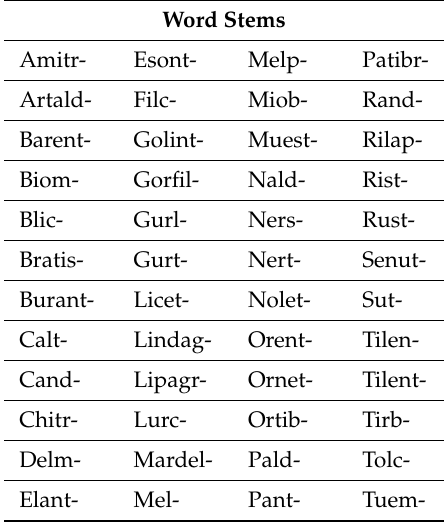
Table 1. List of word stems used for building the pseudonouns.